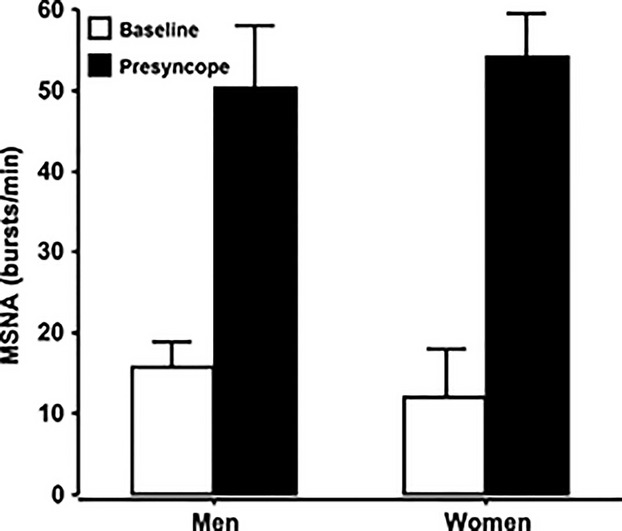
Mean (±95% CI) muscle sympathetic nerve activity at baseline (open bars) and at presyncope (closed bars) in a cohort of high tolerant men and women.